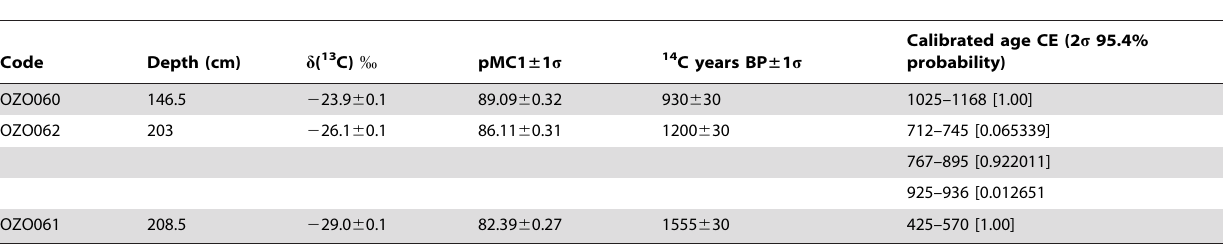
Table 1. Results of AMS radiocarbon dating of wood samples from core TMR/B.